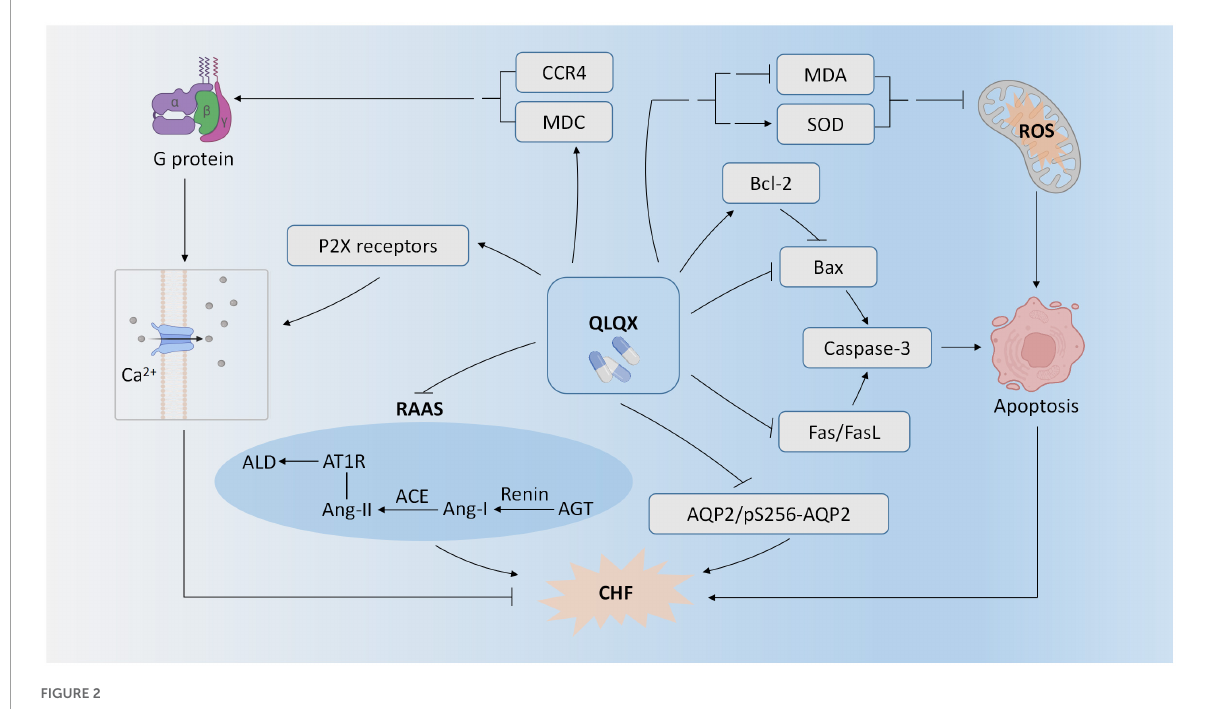
FIGURE2 Potential mechanism of QLQX for